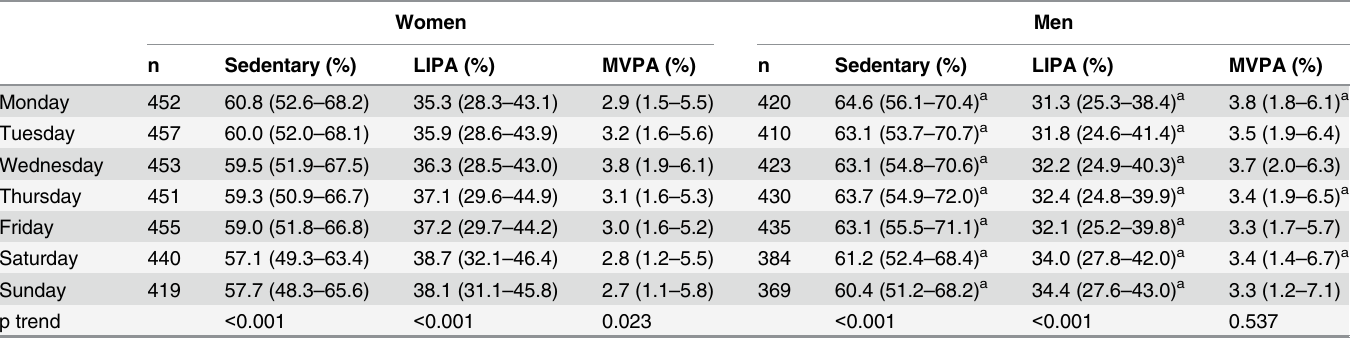
Table 3. Daily movement pattern (% of wear time in different intensity categories) presented per day of the week for women and men, respectively.